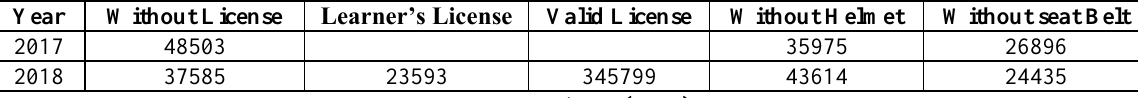
Table 12: Road Accident based on License Type and Non Use of Safety Devices.